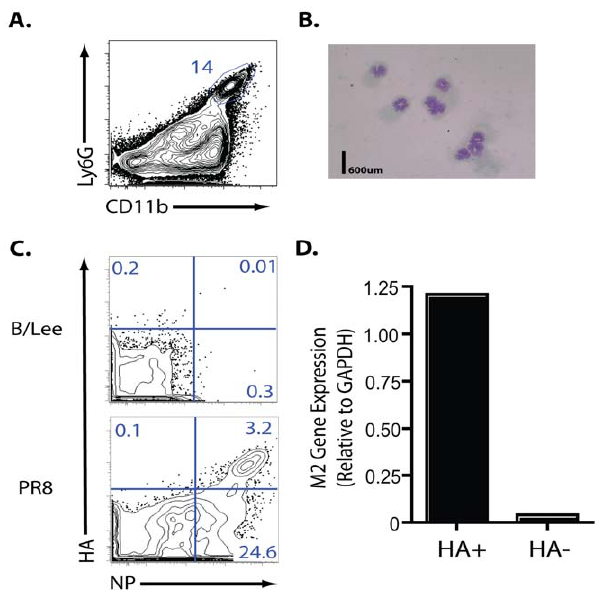
Figure 3. De novo influenza mRNA expression in lung neutrophils. ( A–D ) BALB/c mice were infected with PR8 (10LD 50 ) i.n.. Cells were collected from 4 dpi animals ( A ) BAL fluid flow profile of percent of neutrophils (Ly6G + CD11b hi ). Cells gated previously as CD45 + Thy1.2 2 . ( B ) DiffQuick staining of sorted neutrophils (CD45 + Ly6G + Ly6C int CD11b hi ) ( C ) Representative flow profile of HA + NP + neutrophils at 4 dpi (Cells gated as CD45 + Thy1.2 2 Ly6G + CD11b hi ). B/Lee infected mice were utilized to set flow cytometric gate. ( D ) Influenza M2 mRNA expression (relative to GAPDH) from sorted HA + and HA 2 neutrophils (CD45 + Ly6G + Ly6C int CD11b hi ). Table is representative of one experiment. Additional experiment yielded similar results. ( A–D ) Two independent experiments (n=2–4/expt) represented as mean 6 SEM (where applicable).